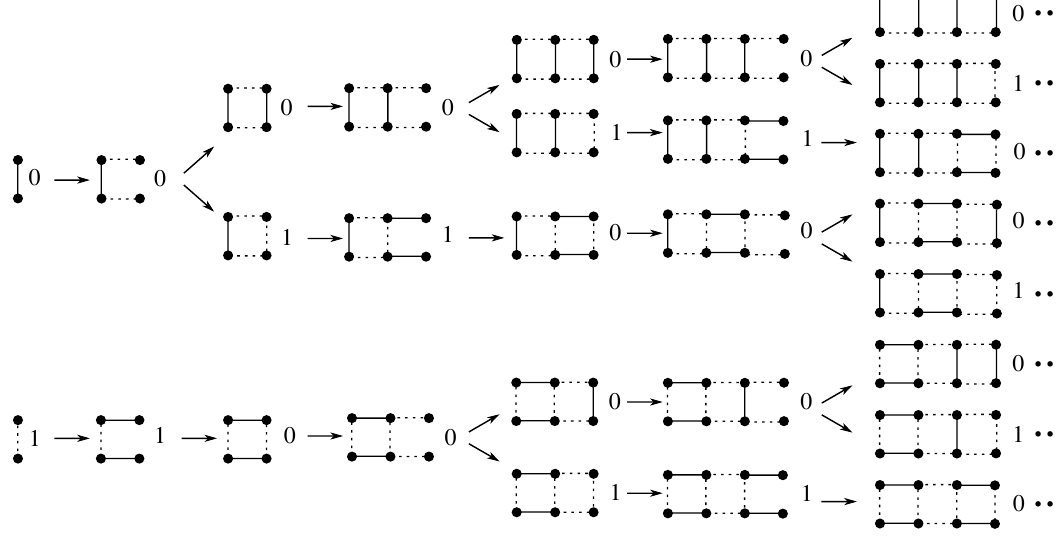
Figure 5: Construction of all possible states of the left block (see main text for details) To summarize, the states of the left environment are labeled by ’0’ and ’1’ with the following rule: For a left subsystem that ends with a rung j , the left environment is labeled by ’1’ if there is no dimer either on the rung ’j’ or on the legs ( j − 1 ) and ( j − 2 ) . Otherwise, the left environment is labeled by ’0’. States that terminate with legs are labeled by the same number as the last rung. This is true because on a ladder attaching two legs does not change the size of the Hilbert space of each sector. This implies that the MPS on the legs can be represented as a block-diagonal matrix that consists of only identity blocks and zero